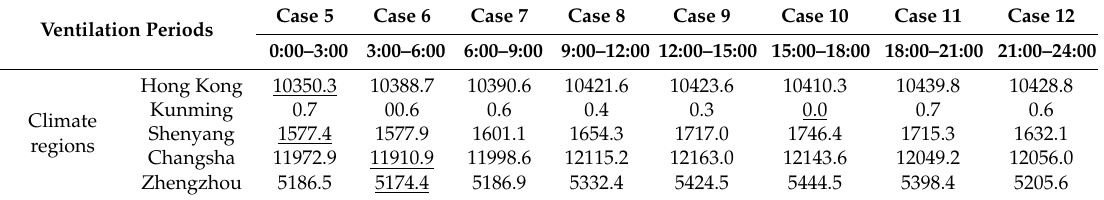
Table 7. I DCT of building models with PCM in different ventilation periods during summer.